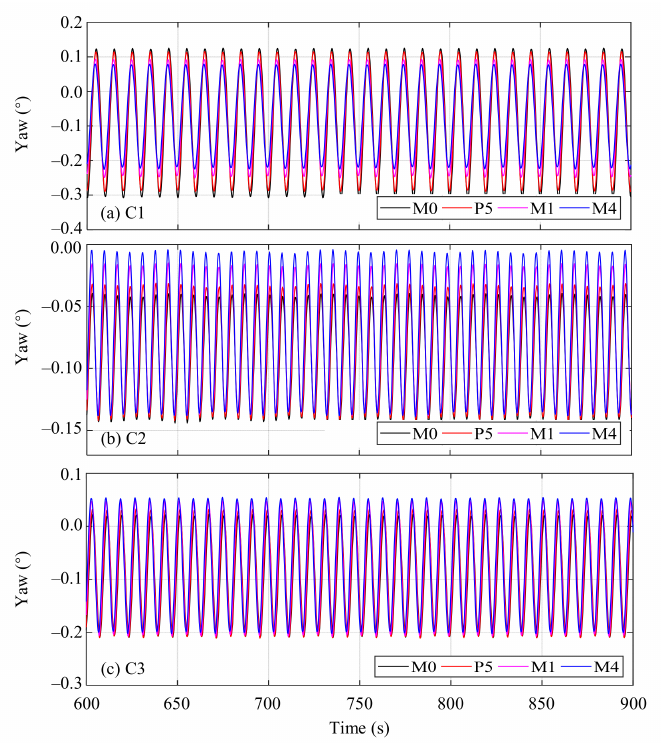
Figure 20. Wind turbine yaw movement time series with M0, P5, M1, and M4 when under: ( a ) C1; ( b ) C2; ( c )